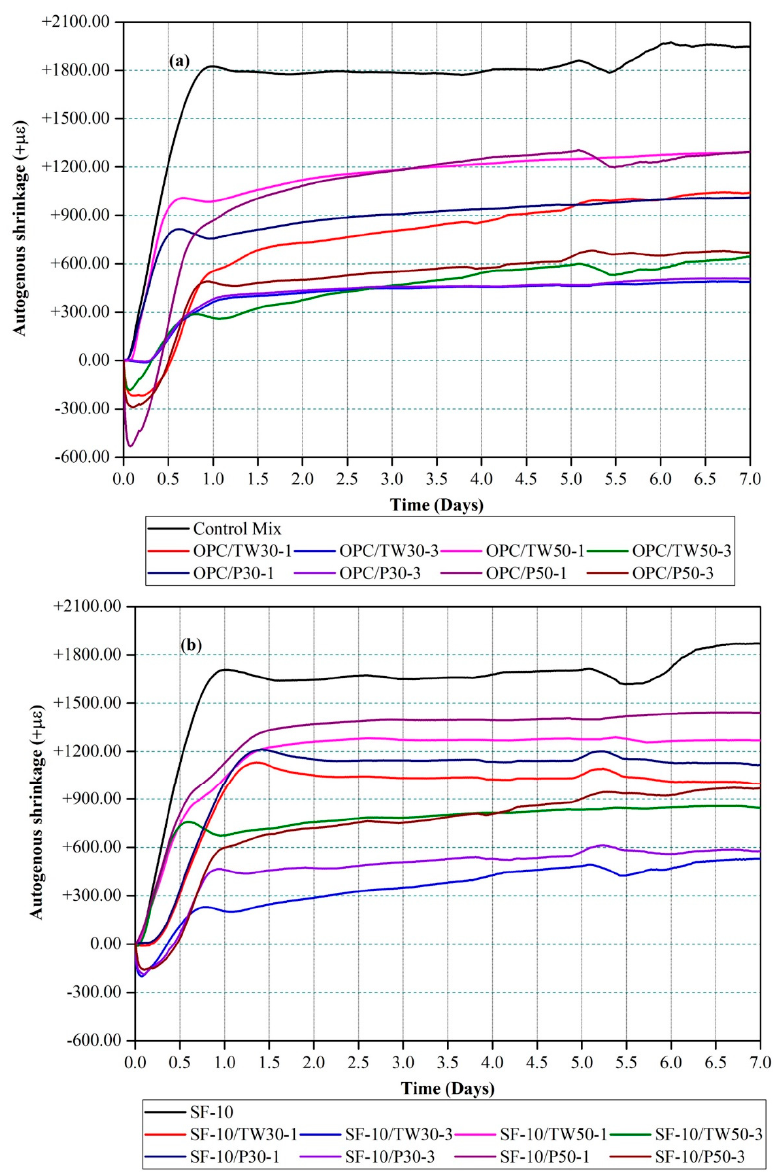
Figure 2. Autogenous shrinkage of mortars made with tea waste and perlite particles. ( a ) 100% OPC and ( b ) 90% OPC and 10% SF. and ( b ) 90% OPC and 10%